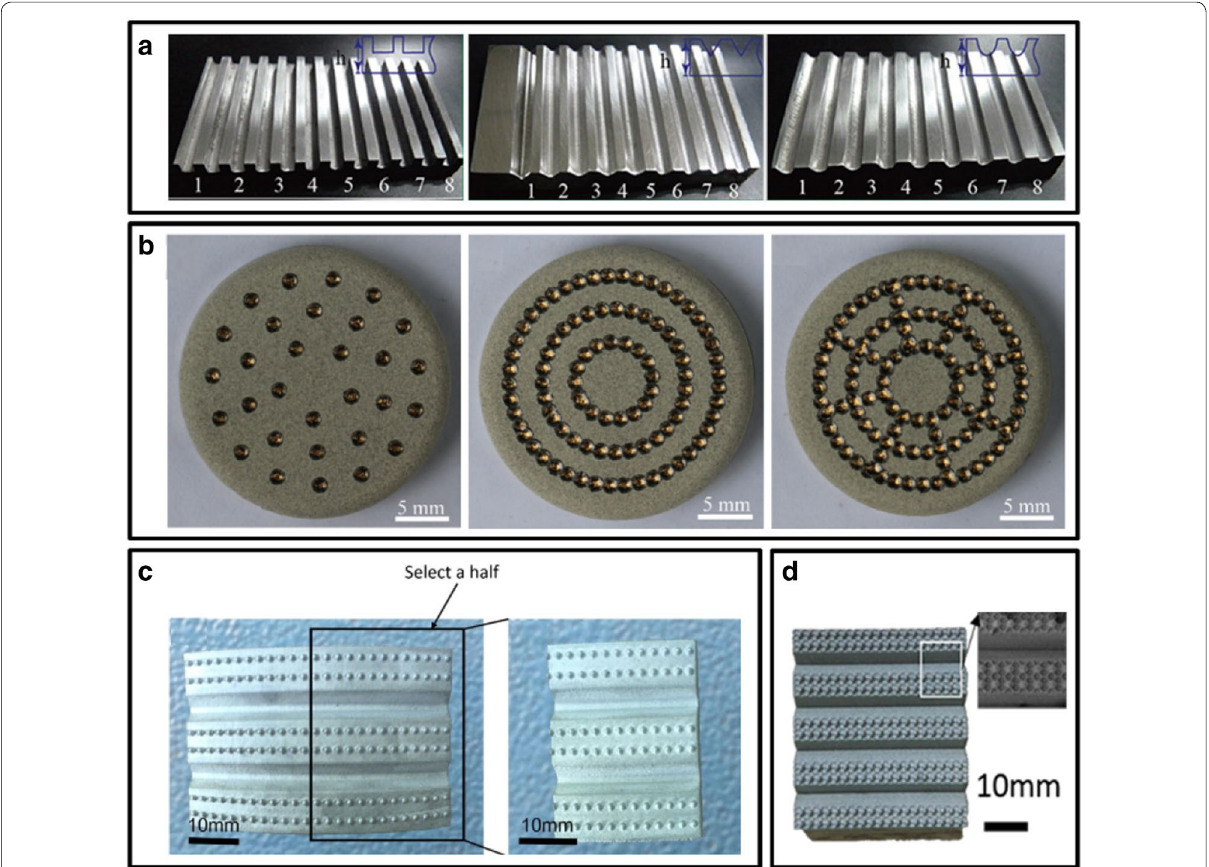
Figure 10 ( a ) Grooves with different shapes (square, U-shaped, and V-shaped), the material is steel-45 [61]; ( b ) Different arrangements of pits [97]; ( c ) A composite structure containing grooves, bumps and curve [66]; ( d ) A composite structure containing grooves, bumps and pits